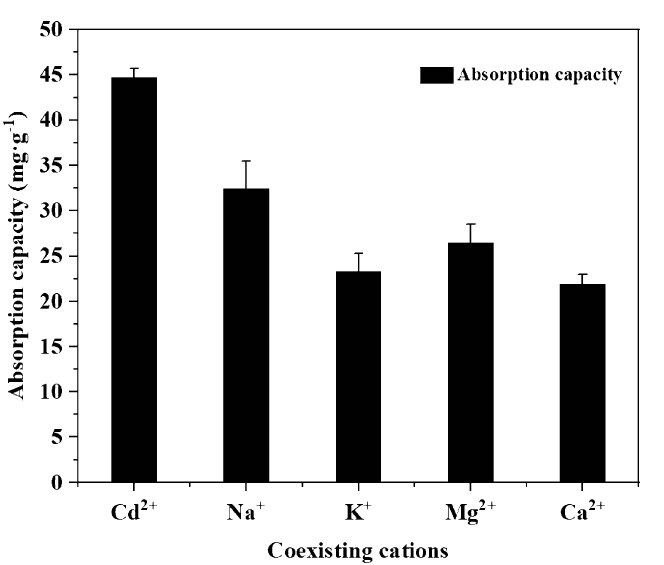
Figure 10. Effect of coexisting cations on the adsorption of Cd 2+ on MRM at pH = 6, T = 25 °C, dosage = 1 g L −1 , t = 240 min and initial Cd 2+ concentration = 50 mg L −1